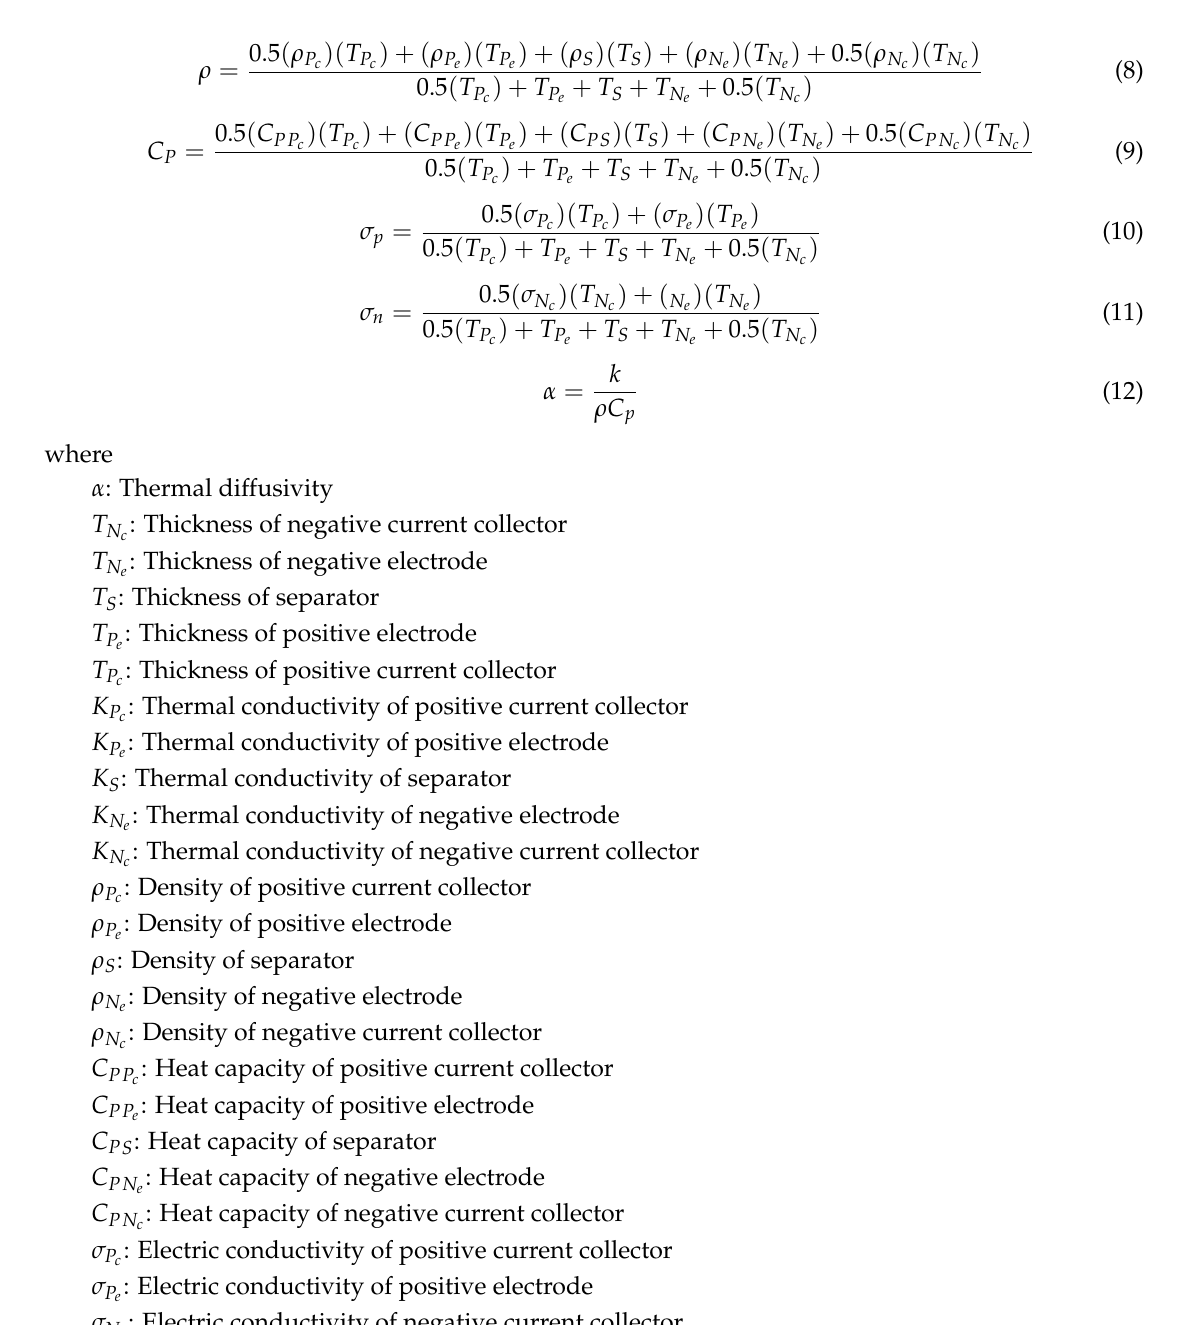
V b I b Figure 6. Equivalent circuit model of the battery. Figure 7. The voltage response of the battery cell to charging and discharging current pulses. V o l t age ( V )